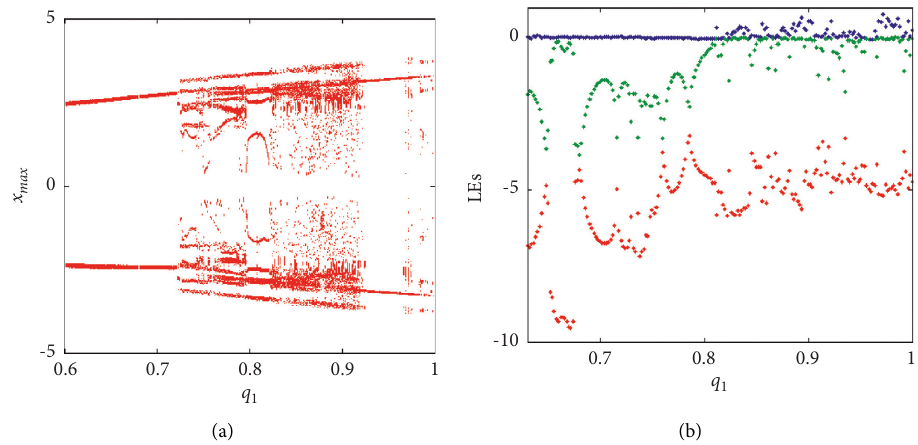
Figure 3: (a) The diagram of bifurcation. (b) Lyapunov exponents of system (4) when q parameters a � 1 and b � − 9 and the IC ( x